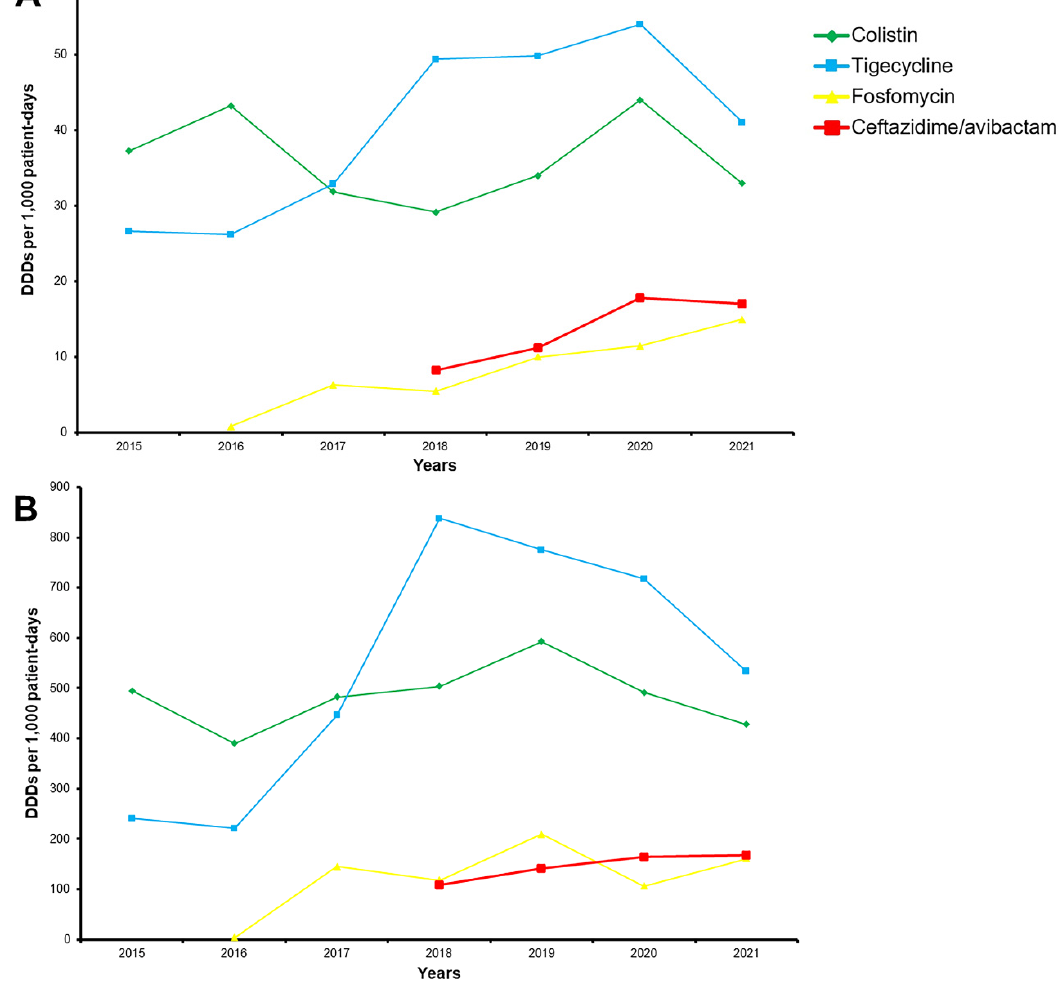
Figure 3. Annual antimicrobial consumption (colistin, tigecycline, fosfomycin, ceftazidime/avibac- tam) in defined daily doses (DDD) per 1000 patient-days; ( A ): all wards; ( B ):